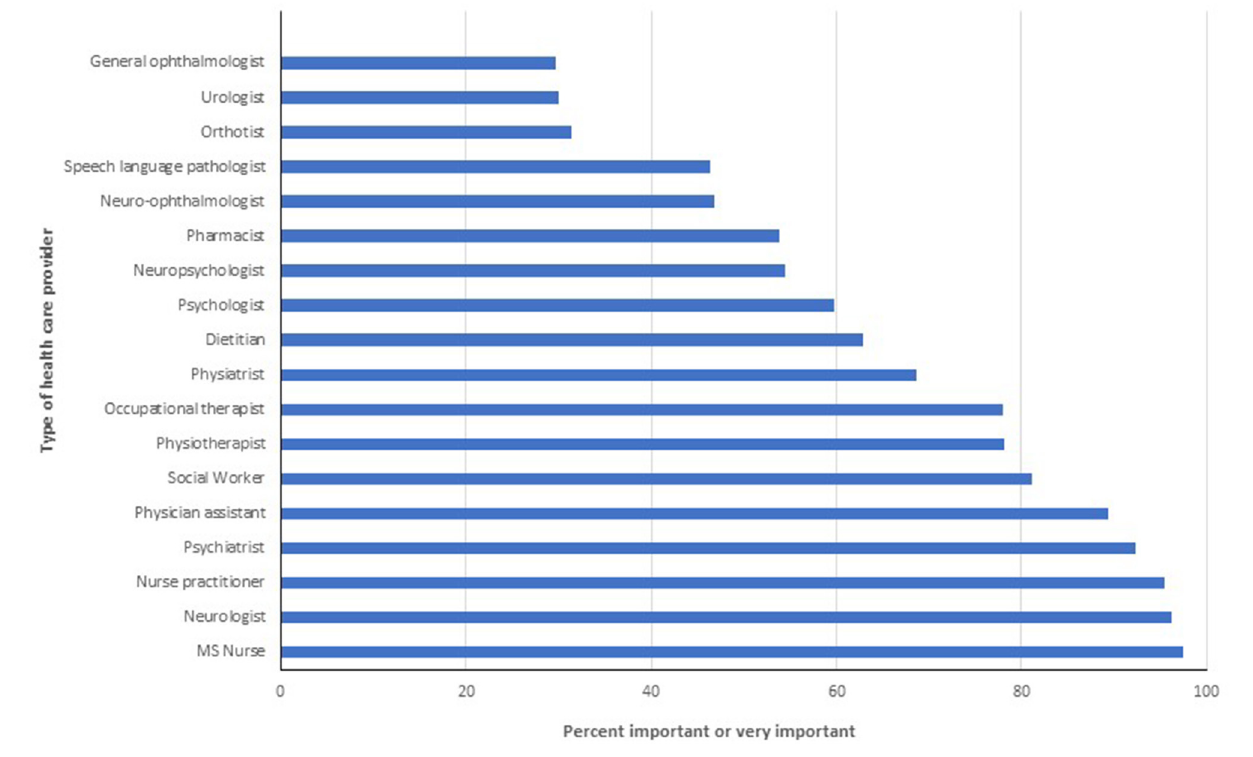
FIGURE 5 | Percentage of respondents indicating it is important or very important that the provider be located within a multiple sclerosis